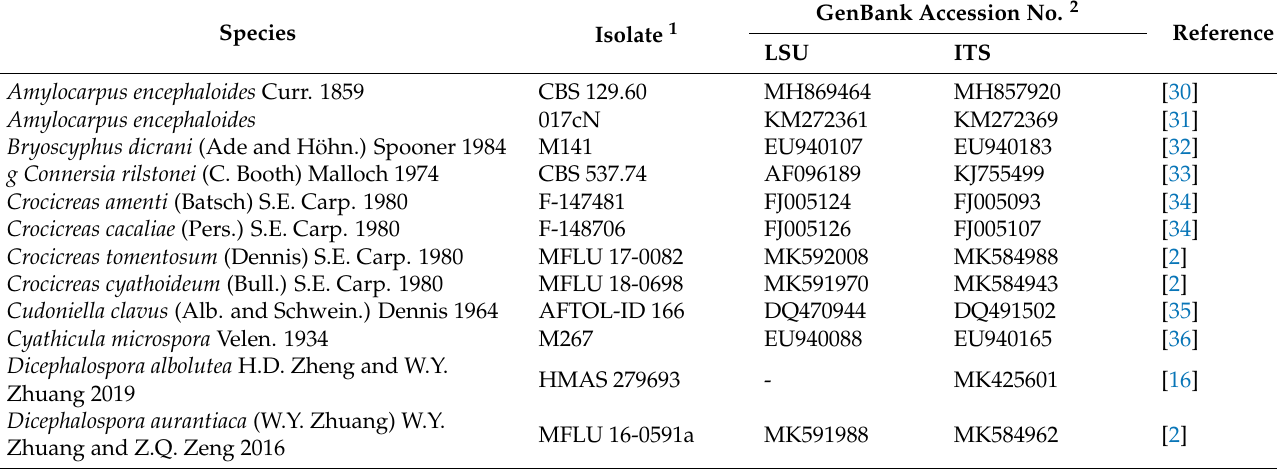
Table 1. Taxa used in the phylogenetic analysis and their GenBank accession numbers. New taxa are printed in bold